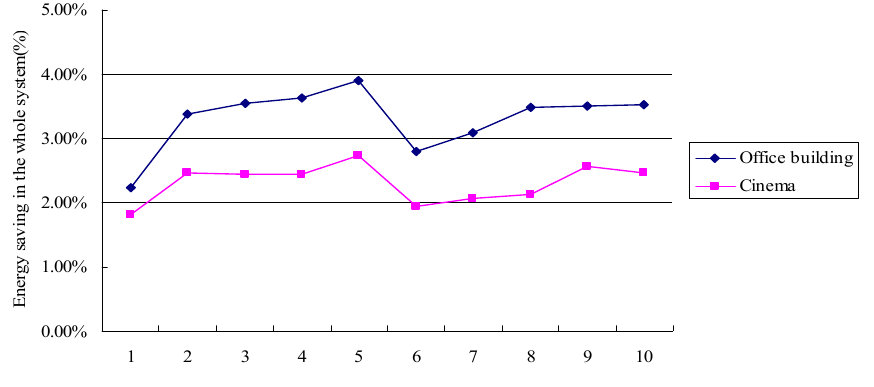
Figure 8. The energy saving in the whole system between the cinema and the office